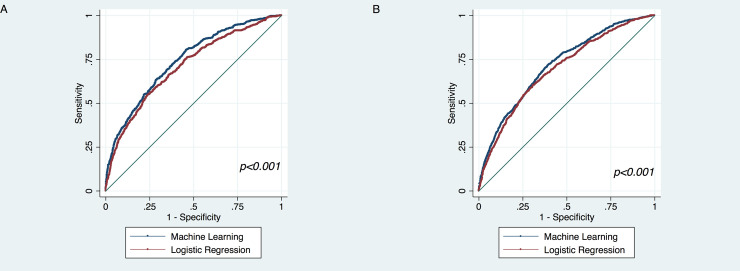
Comparison of area under receiver operating characteristic curves for (A) 90-day mortality and (B) 1-year mortality between the logistic regression and machine learning models.